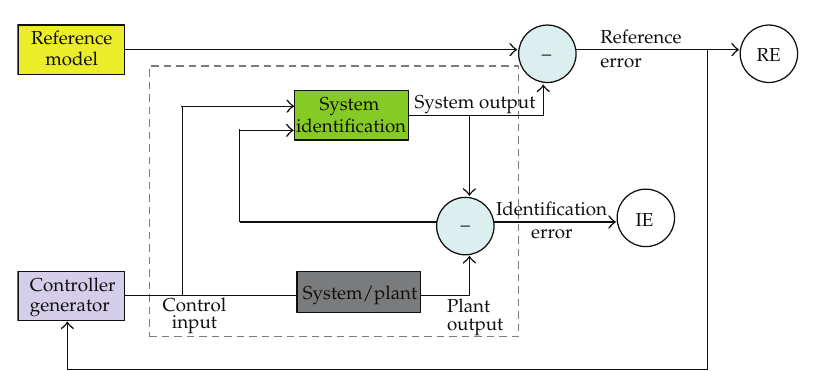
Figure 3: Block diagram of model reference